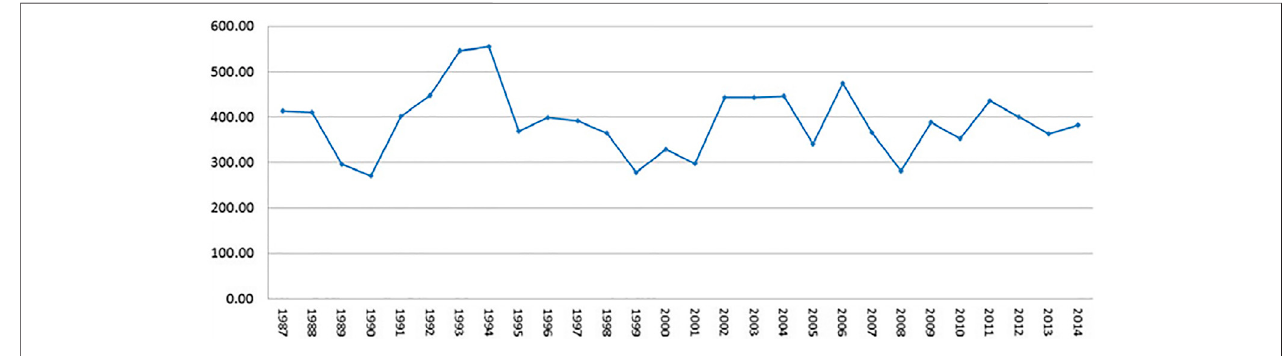
FIGURE 5 | Precipitation changes trends in LU basin from 1987 to 2014.